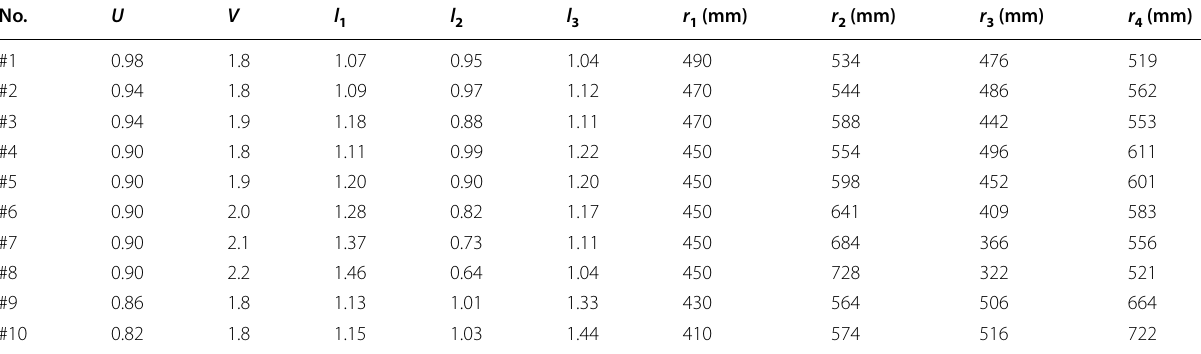
Table 1 Selected candidates for architecture